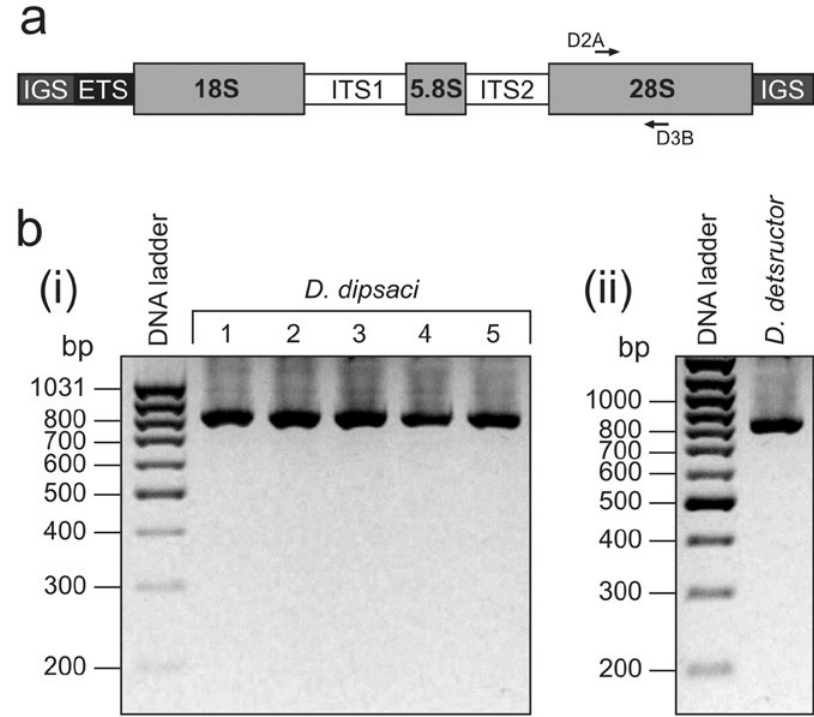
Figure 1. Amplification of D2D3 expansion segments of the 28S-LSU rRNA gene. a. Schematic representation of the nu - clear ribosomal DNA array. PCR primer-representing arrowheads indicate amplified D2D3 expansion segments of the 28S rRNA gene. IGS, intergenic spacer; ETS, external transcribed spacer; ITS, internal transcribed spacer; 18S, 5.8S and 28S rRNA genes. b. Agarose gels of D2-D3 28S rDNA amplicons for Ditylenchus dipsaci (i) and D . destructor (ii). Lanes: 1, D . dipsaci isolate from Cichorium inthybus ; 2, D . dipsaci isolate from Allium sativum ; 3, D . dipsaci isolate from Narcissus sp.; 4, D . dipsaci isolate from Pisum sativum ; 5, D . dipsaci isolate from Medicago sativa . MassRuler MixDNA ladder